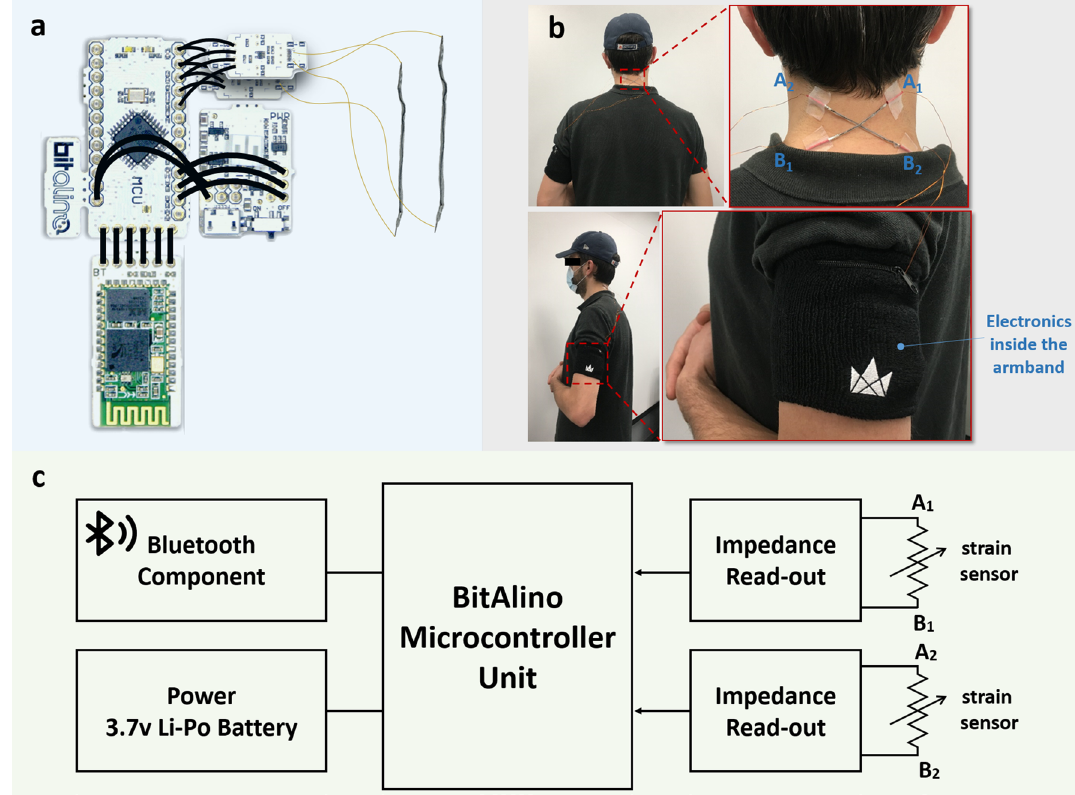
Figure 3. Circuit schematics and overall system. ( a ) Circuit ( b ) Thread placement on the back of the neck ( c ) Circuit